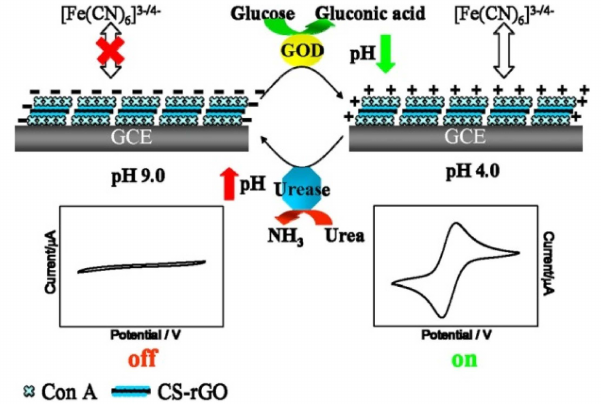
Figure 3. Con A-coated glassy carbon electrode as a pH-sensitive ion gate for glucose and urea sensing. Reprinted with permission from Analytical Chemistry. Copyright 2014 American Chemical Society